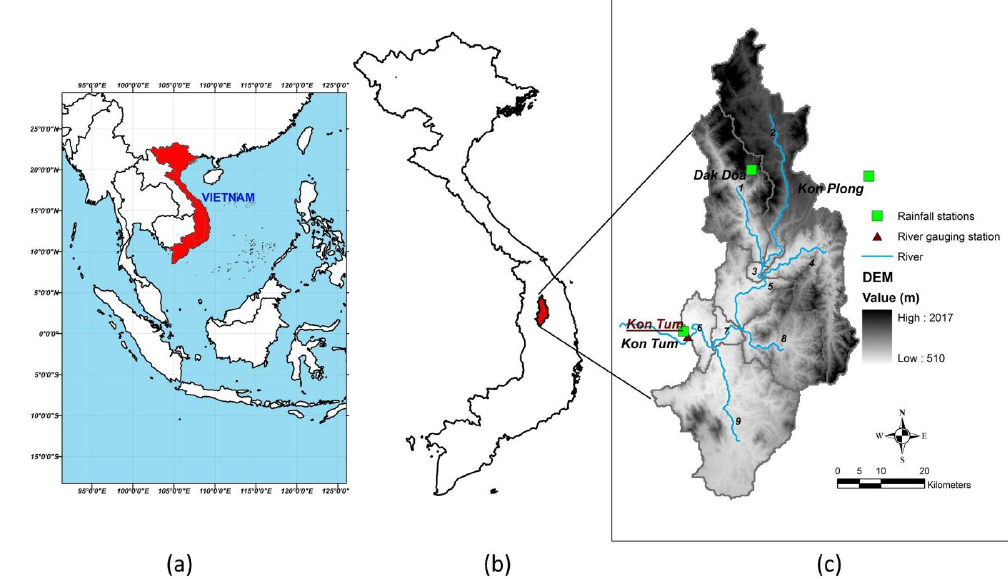
Figure 1. Study region 2 Fig. 1. Study region: (a) the country Vietnam is shown within the Southeast Asia region; (b) the location of the catchment in Vietnam; (c) the catchment area that measures the runoff at the downstream end of the